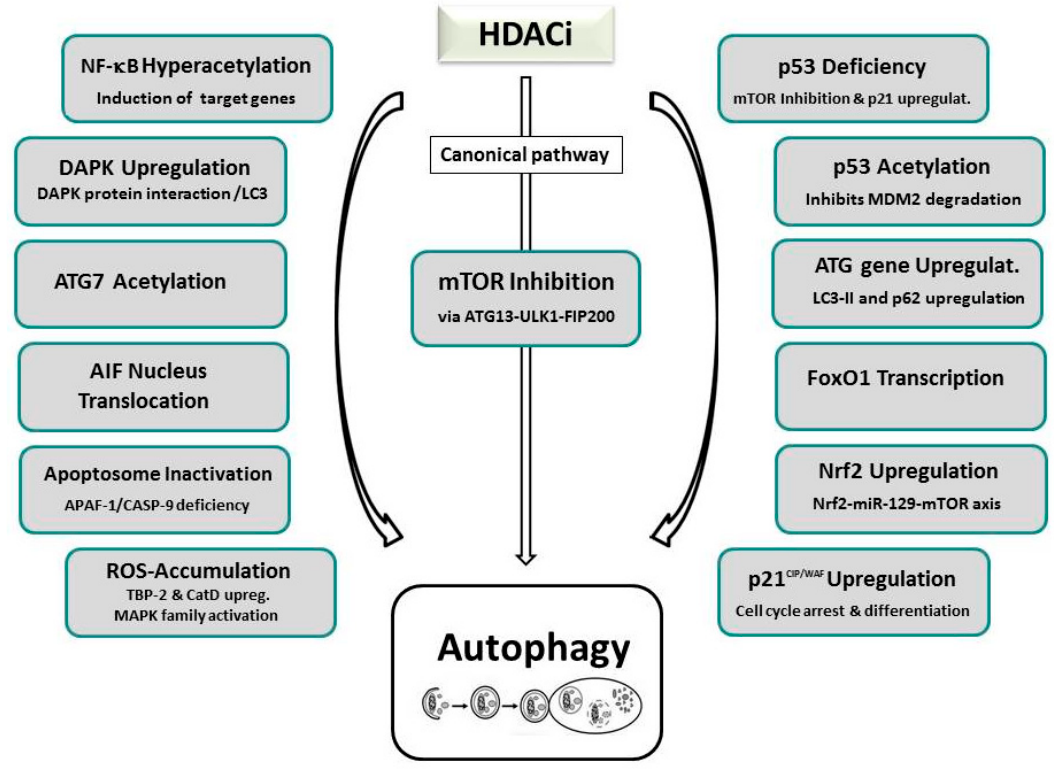
Figure 2. Known mechanisms and signaling pathways involved in histone deacetylase inhibitor-activated induction or suppression of autophagy. In most cases mTOR inhibition representing the canonical pathway, ROS accumulation, NF- κ B hyperacetylation, p21 upregulation, or the involvement of p53 signaling is observed.